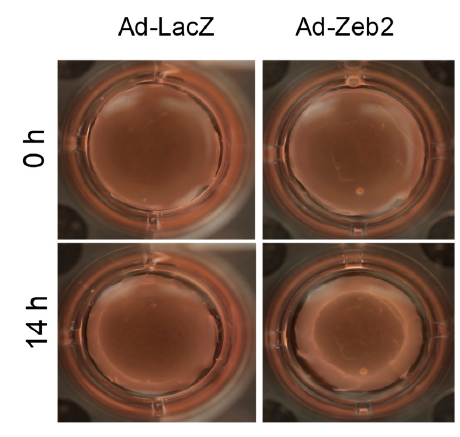
Figure 3. Zeb2 overexpression inhibits the migration of P1 myofibroblasts. ( A ) P1 myofibroblasts were transduced with Ad-EGFP or Ad-HA-Zeb2 and incubated for 96 h. After 96 h, culture inserts were removed and images were taken at the indicated time points (4× objective). ( B ) The number of cells in the wounded area was quantified using ImageJ software. Histographic representation shows the number of migrated cells in Ad-EGFP (200 MOI) and Ad-Zeb2 (200 MOI) infected plates. n = 3, * p ≤ 0.05 vs Ad-EGFP at 18 h. Error bars represent SEM. Data were analyzed by performing a Student’s t -test.